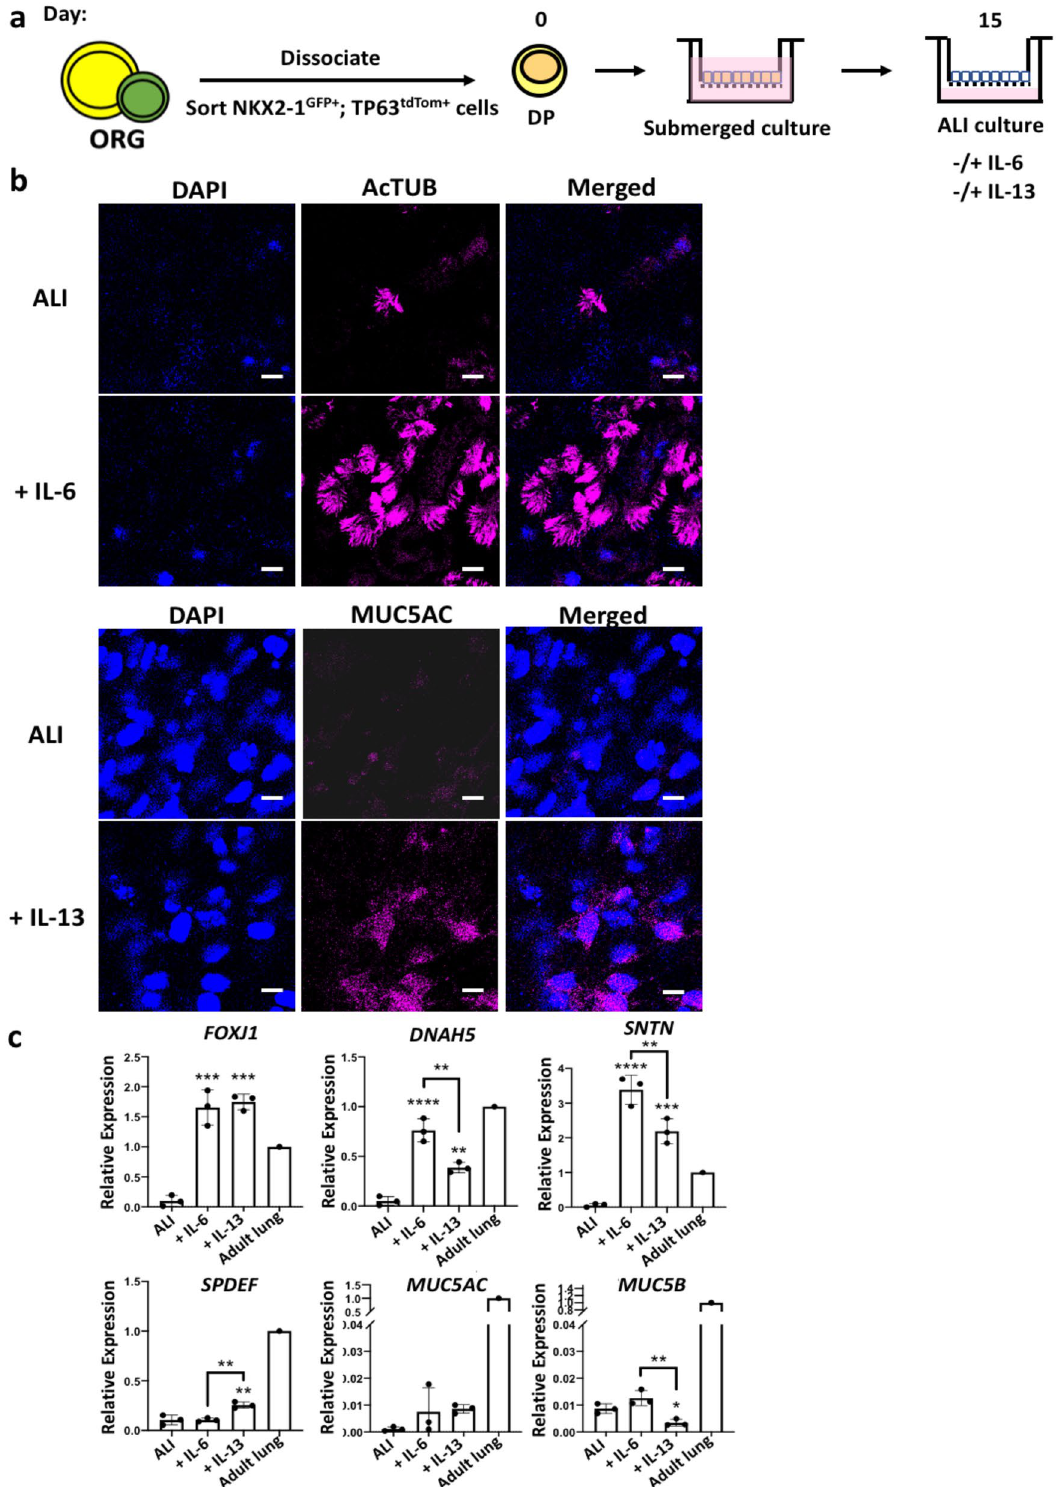
Figure 8. DP cells possess multilineage differentiation potential. ( a ) Schematic of differentiation protocol. Isolated DP cells were seeded onto transwells and then cultured at an air–liquid interface (ALI) upon reaching confluence in the absence or presence of 10 ng/ml IL-6 or 10 ng/ml IL-13. ( b ) Representative images of differentiation cultures immunostained for acetylated α-tubulin (AcTUB) and MUC5AC. Scale bars indicate 5 µm. n = 3. ( c ) QPCR analysis of multiciliated cell markers ( FOXJ1 , DNAH5 , SNTN ), secretory cell markers ( SPDEF , MUC5AC , MUC5B ). n = 3. Graphs were made and statistical analyses were done using GraphPad Prism 8.0 (GraphPad Software Inc., San Diego, CA, USA) (www.graph